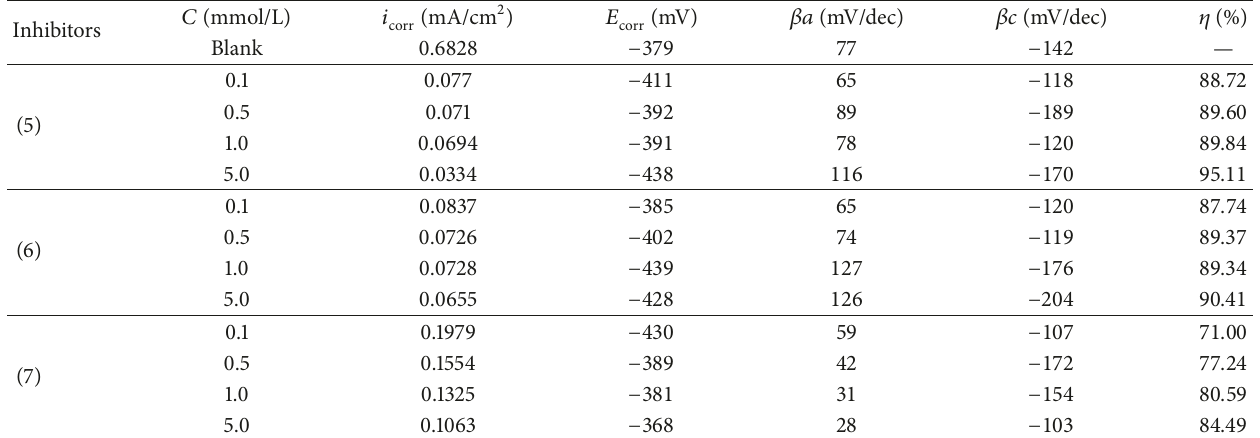
Table 2: Electrochemical parameters for the corrosion of steel in 1 MHCl containing different concentrations of Camphor thiosemicarbazone (5) , Carvone thiosemicarbazone (6) , and Pulegone thiosemicarbazone (7) .